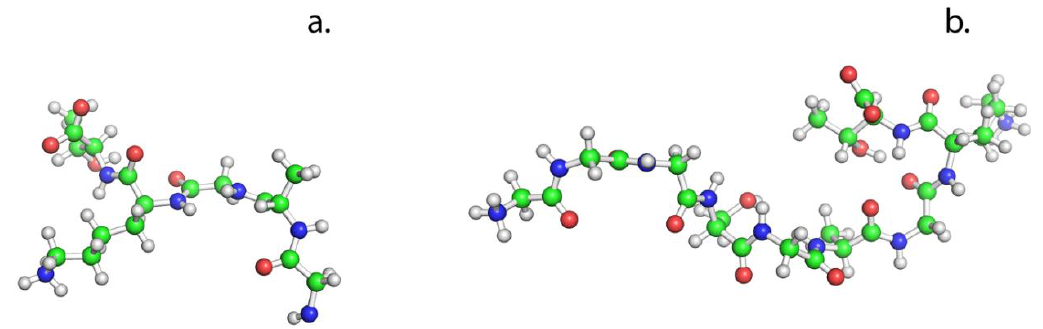
Figure 1. Chemical representation of the two peptides. ( a ) AGKT (375 Da) and ( b ) GGG SGA GKT (692 Da). The peptides are constructs based on the amino acid configuration described by Bianchi et al. [28]. The peptide amine (N–H) backbone groups form a ‘nest’ structure toward phosphate anions and the Lysine side chain participates in the binding when phosphorous compounds are present. Color code: green = C, blue = N, red = O, and white = H.